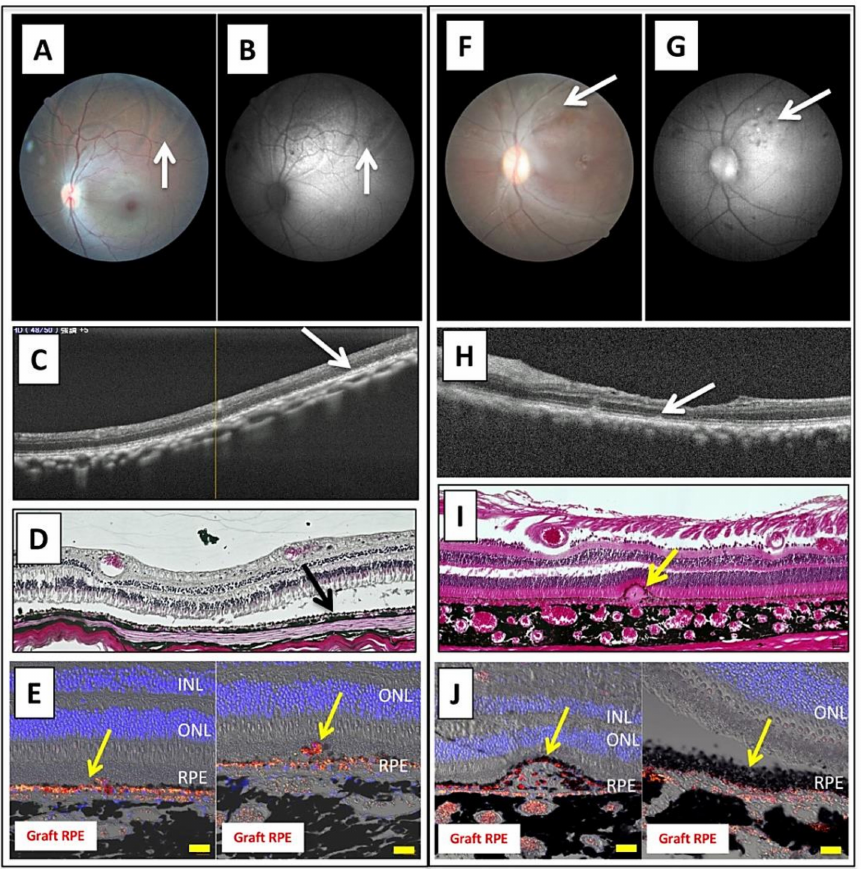
Figure 7. Transplantation of allogeneic iPS-RPE cells with Y-27632 in MHC haplotype-matched or steroid-administrated monkeys. ( A – E ) MHC haplotype-matched donor: ( A ) color fundus, ( B ) AF fundus, ( C ) OCT, ( D ) H&E staining, ( E ) IHC staining. Pigmented graft RPE cells are seen in the left eye (arrows). Grafted cells survived and there were no rejection signs in OCT ( C ), H&E ( D ), and IHC staining ( E ). In addition, we found PKH-labeled iPS-RPE cells (graft RPE, red) through the retinal sections. Scale bar = 20 µ m. ( F – J ) MHC-mismatched steroid administration donor: ( F ) color fundus, ( G ) AF fundus, ( H ) OCT, ( I ) H&E staining, ( J ) IHC staining. We obtained similar results for the MHC-mismatched donor with immunosuppressive drugs and local steroid administration. In these examinations such as color fundus ( F ), AF ( G ), OCT ( H ), H&E staining ( I ), and IHC staining ( J ), there was graft survival of iPS-RPE cells in the subretinal space. We also found PKH-labeled iPS-RPE cells (graft RPE, red) throughout the retinal sections. Scale bar = 20 µ